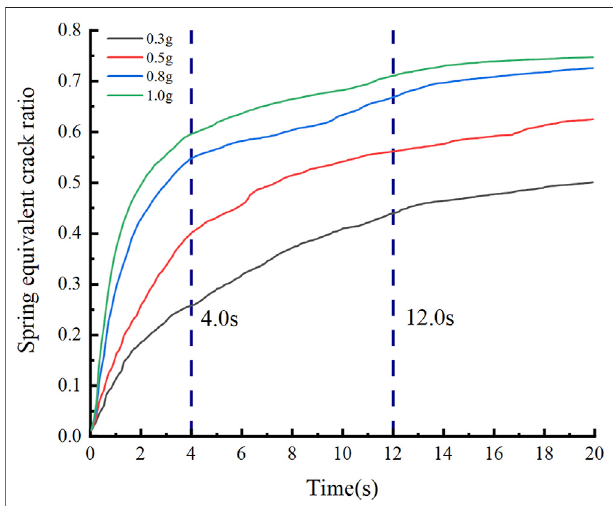
FIGURE11| Variationofspringequivalentcrackratiowithampli fi cations (weak interlayers dip is 45 ° ).